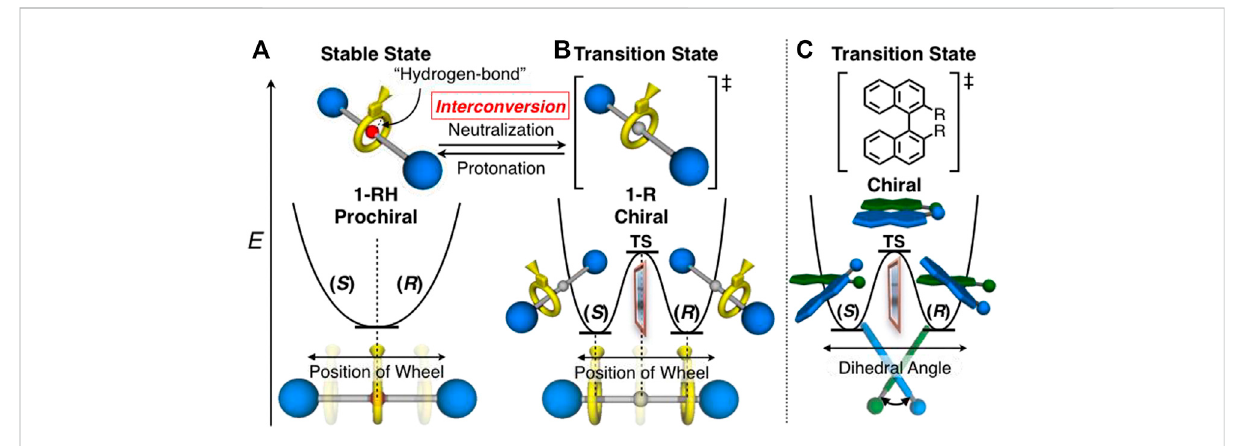
Chiral-prochiralinterconversionandenergydiagrams of (A)1-RH , (B)1-R (seealsoScheme1andFigure5AandSupplementaryFigureS50)and (C) axially chiral 1,1 ′ -binaphtyl derivatives for